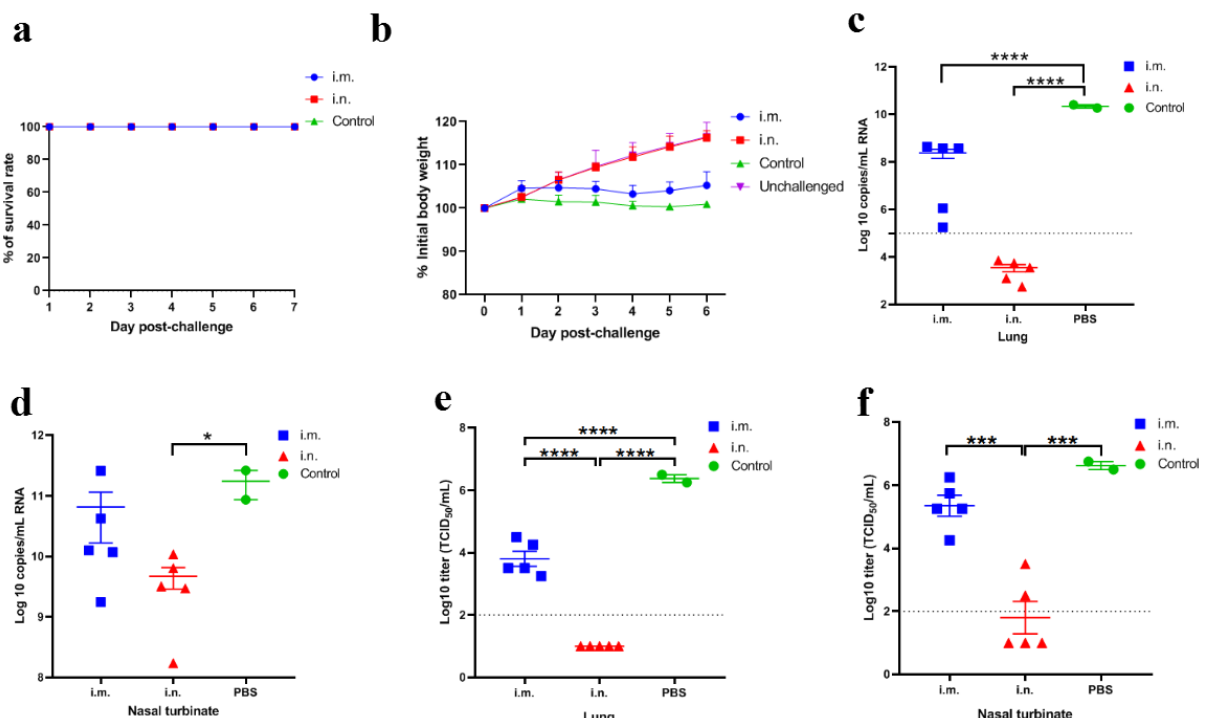
Figure 4. Protective efficacy of rVSV-ΔG-S in golden hamsters following SARS-CoV-2 challenge. i.m., i.n. and control refer to i.m. ( n = 5), i.n. inoculation group ( n = 5) and PBS inoculation group ( n = 2) who were challenged with SARS-CoV-2, respectively (same in Figure 2b–f). Unchallenged control refers to hamsters inoculated with PBS and free from SARS-CoV-2 challenge ( n = 6). ( a ) Survival rate following SARS-CoV-2 challenge. ( b ) Body weight change in golden hamsters following SARS-CoV-2 challenge. ( c , d ) SARS-CoV-2 viral RNA copies in the lungs and nasal turbinates following SARS-CoV-2 challenge. ( e , f ) SARS-CoV-2 viral titers in the lungs and nasal turbinates following SARS-CoV-2 challenge. Data are presented as mean ± SEM. (* p < 0.05, *** p < 0.001, **** p < 0.0001). Lung sections of challenged animals were stained with hematoxylin-eosin (H&E) and subjected to immunohistochemistry (IHC) (Figure 5). H&E staining showed that the lung tissue structure of the challenged PBS inoculation group was moderately abnormal, thick- ened alveolar wall, proliferated epithelial cells (yellow arrow), broken alveolar diaphragms and atrophic alveoli (red arrow) were observed. In the i.m. inoculation group, the lung tissue structure was moderately abnormal, damaged alveolar structure and thickened local alveolar wall were observed (yellow arrow). The nuclei of alveolar epithelial cells were clear. No inflammatory cell infiltration was found in the lung parenchyma. In the i.n. inoc- ulation group and the unchallenged control group, the lung tissue structure was normal, the alveolar wall in the visual field was uniform and there was no thickening, the alveo- lar outline was clear and the size was normal, the alveolar epithelial nucleus was round without necrosis. No inflammatory cell infiltration was found in the lung parenchyma. Immunostaining of SARS-CoV-2 antigen showed that i.n. inoculation significantly reduced the viral infection in the lungs, while a large amount of SARS-CoV-2 infection could be detected in the lung tissues of animals in the i.m. immunization group and PBS inoculation control group (red